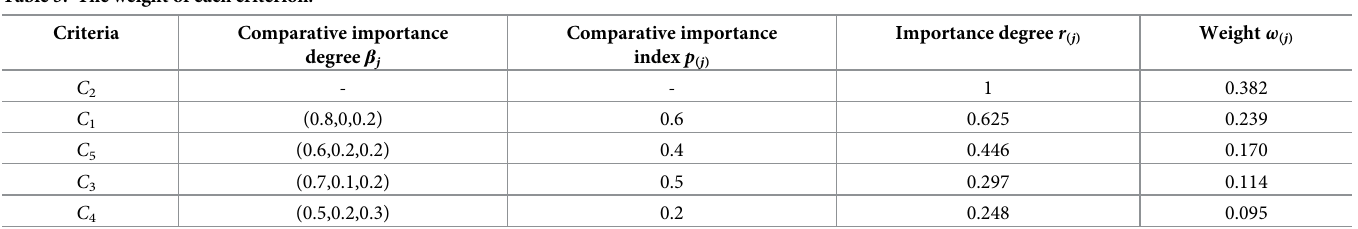
Table 3. The weight of each